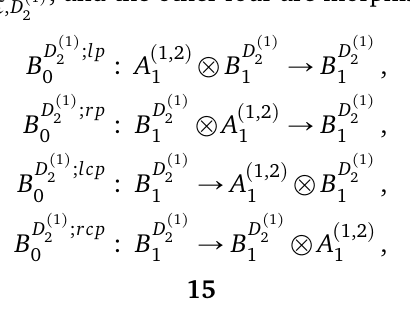
Figure 12: Construction of various morphisms comprising the algebra A p 1,2 q . D p 1 q where B